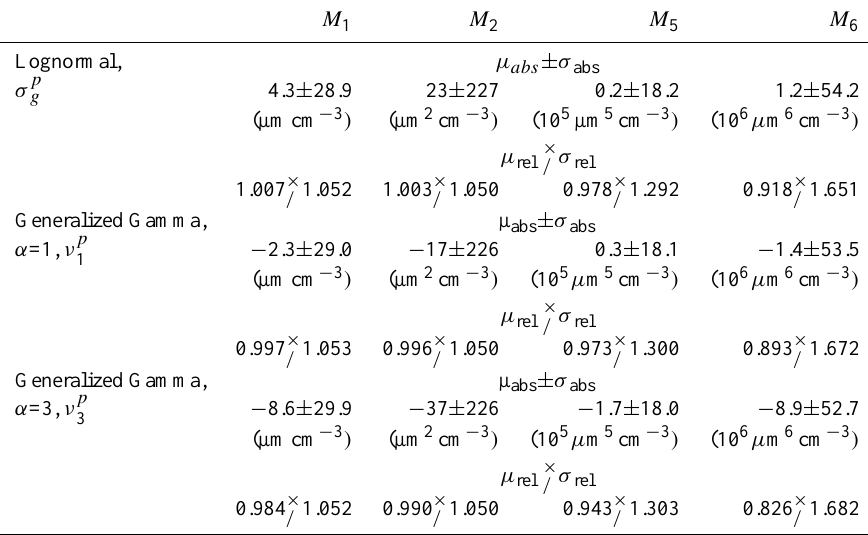
for the GG1 and ν p for the 1 3